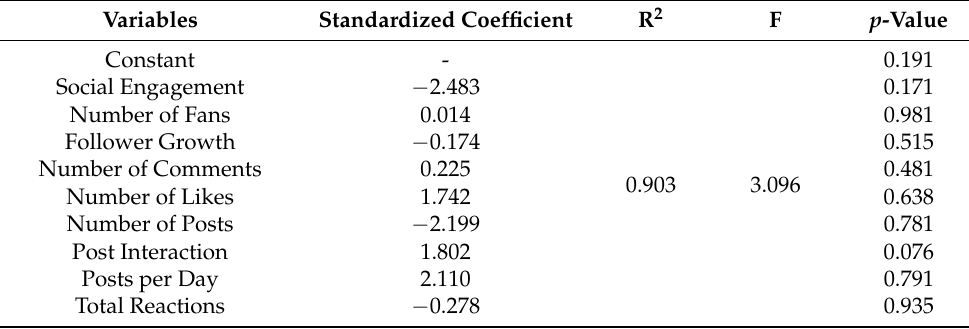
Table 5. Impact of social media analytics on CPNs websites’ organic